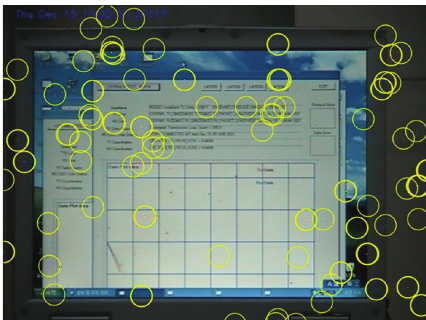
Figure 3: Experimental setup for the notebook PC under a high dose-rate gamma ray irradiation test.